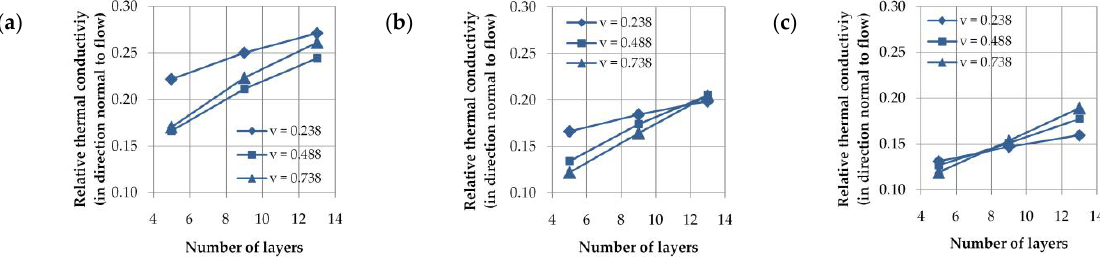
Figure 14. Relative transverse thermal conductivity of porous medium as a function of the number of layers in a bedcontaining balls with a diameter of ( a ) 2 mm, ( b ) 3 mm, ( c ) 4 mm.